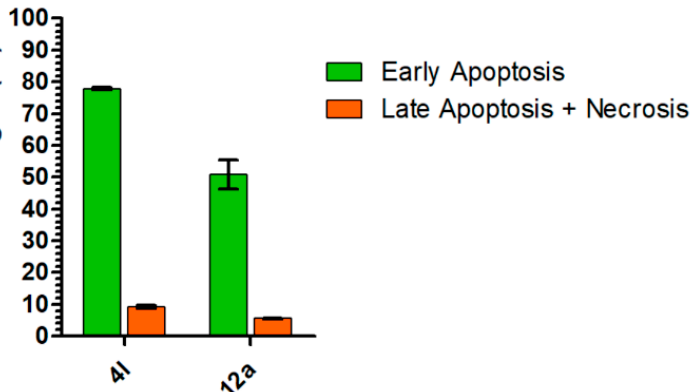
Figure 5. Percentages of early apoptotic (green bars) and late apoptotic (orange bars) A549 cells 24 h after exposure to compounds 4l (1 µM) and 12a (5 µM). Each value represents the mean ± SD of 3 measurements.